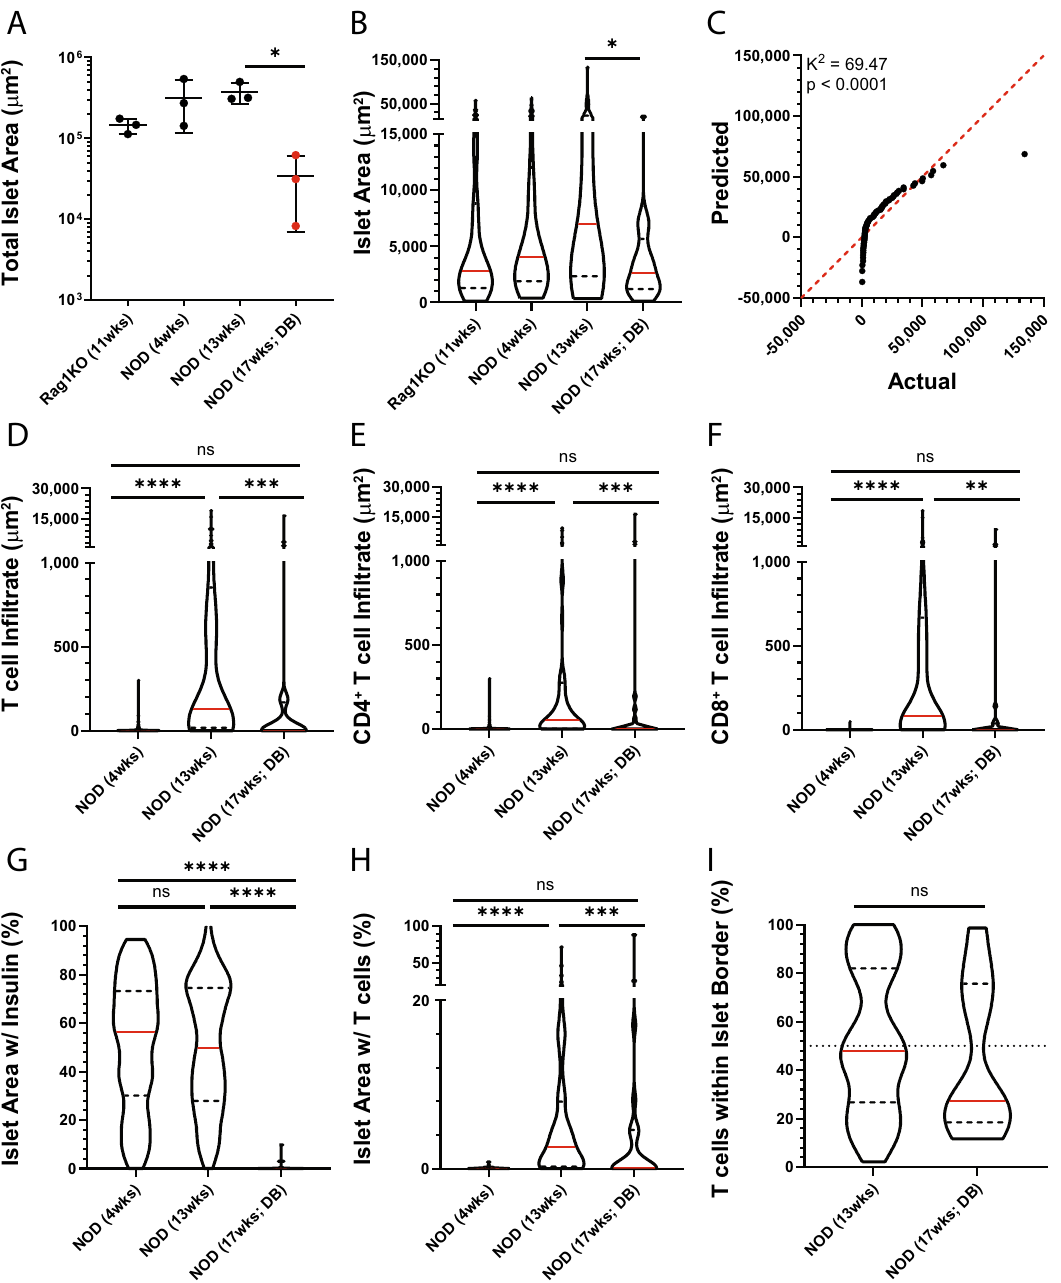
Figure 6. Quantitative islet analysis enables numerous metrics to assess islet inflammation throughout progression of T1D. Individual islet images from 4-week-old (n = 93), 13-week-old non-diabetic (n = 71) and 17-week-old diabetic NOD mice (n = 23) were pooled within each group (n = 3/group) and analyzed for quantification of islet area and inflammation. ( A ) Sum of total islet area for all islets imaged from each mouse. ( B ) Individual islet area from islets pooled from all mice of a given strain and age. ( C ) Quantile–quantile plot of actual individual islet areas from 13-week-old non-diabetic NOD mice, as in ( B ), compared to values predicted from a normally distributed Gaussian data set. ( D – F ) T cell infiltration of individual islets pooled from all mice of a given age. ( D ) T cell infiltration was assessed as combined CD4 + and CD8 + T cell infiltration as well as independent ( E ) CD4 + and ( F ) CD8 + T cell infiltration. ( G – I ) Metrics assessing the proportional contributions of insulin or T cell signals based on their position relative to the defined islet border of individual islets pooled from all mice of a given age. ( G ) Proportion of islet area occupied by insulin signal. ( H ) Proportion of islet area occupied by combined CD4 + and CD8 + T cell signal. ( I ) Proportion of total T cell inflammation that falls within the islet borders. Solid red lines on violin plots depict the median and dotted black lines depict the first and third quartiles. Dotted line at 50% represents a break point representing a conversion from peri-insulitis to insulitis. “DB” refers to diabetic mice. Red dots represent data points from diabetic mice. Kruskal–Wallace test with post- hoc Dunn’s multiple comparison test was performed to determine statistical significance. Data are representative of three independent experiments. * p < 0.05, ** p < 0.01, *** p < 0.001, **** p < 0.0001. ns not